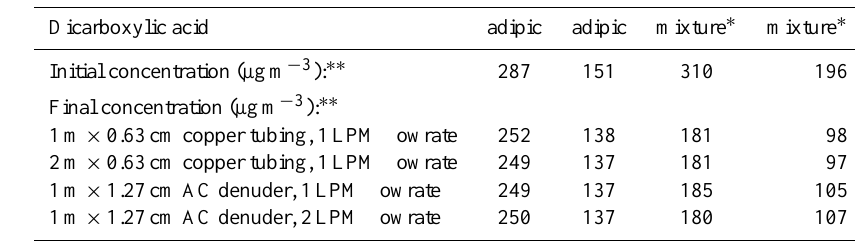
Table 3. Initial (upstream of the heating section) and final (downstream of the cooling section) measured aerosol loadings for different cooling section configurations.